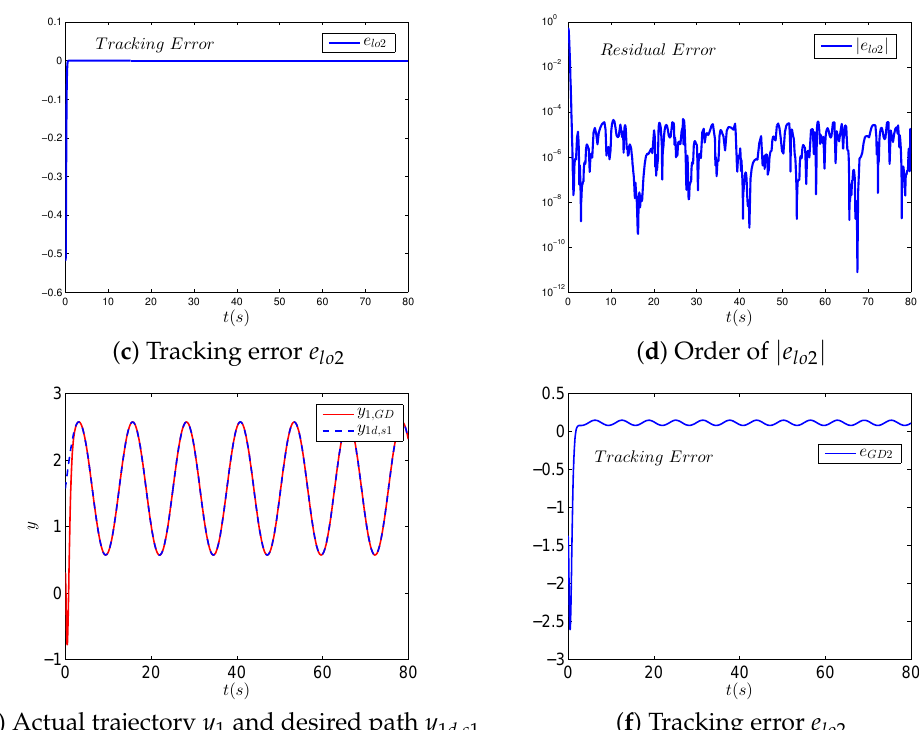
Figure 4. Tracking performance of ZD and GD controller (21) to solve the tracking control problem with single linear output of the single-link manipulator with flexible joints for the desired path y 1 d , s 1 = π sin ( t ) /4 + π